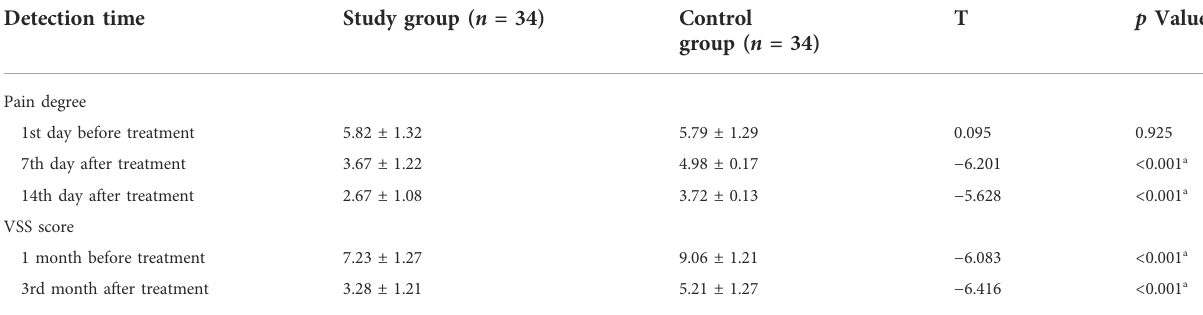
TABLE 6 Comparison of pain degree and scar status between two groups (Mean ± Standard